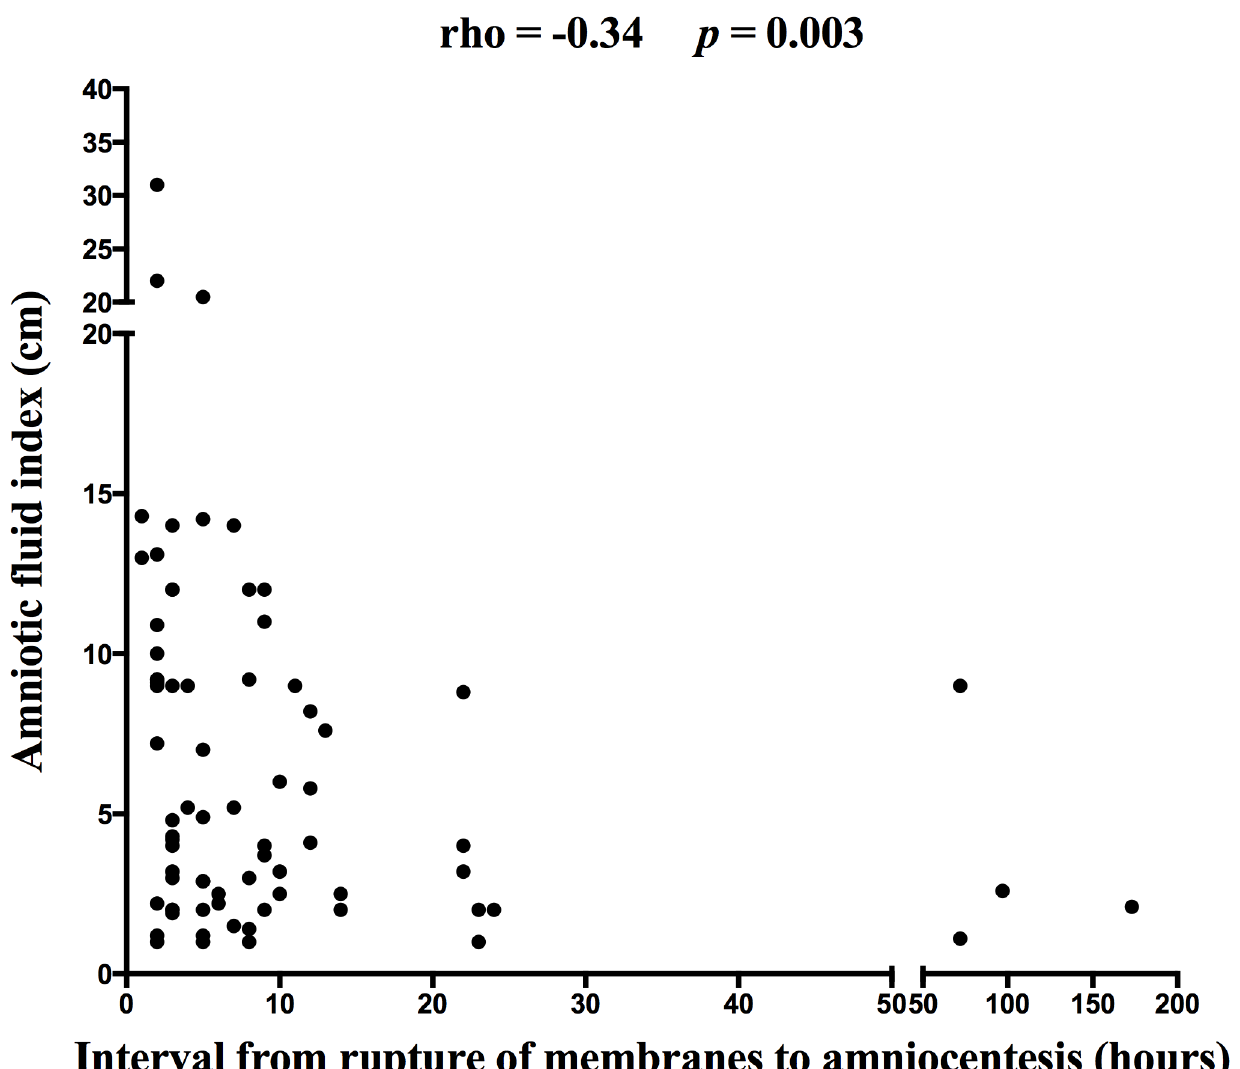
Figure 2. The correlation between the amniotic fluid level determined by the amniotic fluid index (cm) and an interval from PPROM to amniocentesis (hours).